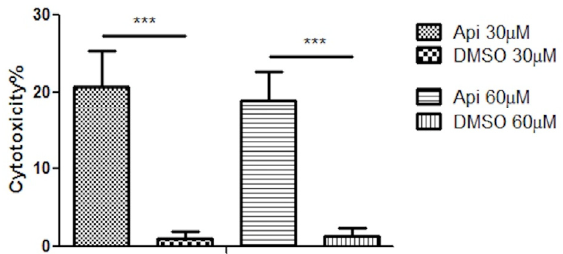
Figure 6. The cytotoxic e ff ect of Api and DMSO at 30 µ M and 60 µ M concentrations on the human melanoma A375 cell line after 72 h exposure time. *** p < 0.001.